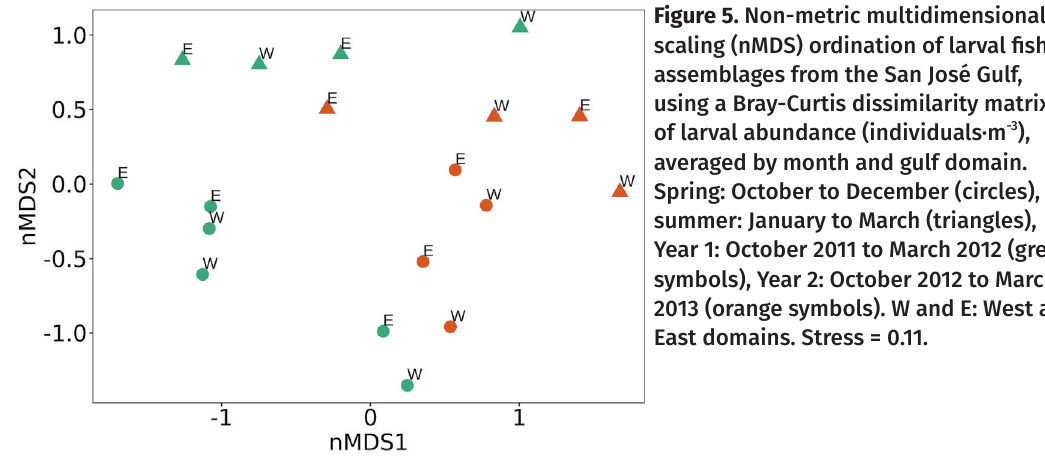
Figure 5. Non-metric multidimensional scaling (nMDS) ordination of larval fi sh assemblages from the San José Gulf, using a Bray-Curtis dissimilarity matrix of larval abundance (individuals·m -3 ), averaged by month and gulf domain. Spring: October to December (circles),